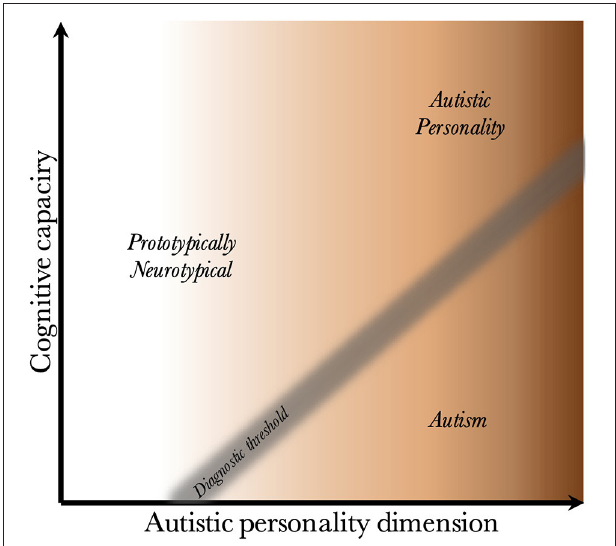
FIGURE 4 | The autistic personality type in relation to neurotypical individuals and those with autism. Illustration how the two clinically neurotypical groups above the diagnostic threshold compare with diagnosed individuals. It shows that individuals with an autistic personality differ from prototypically neurotypical individuals with regard to their position on the autistic personality dimension. It also shows that the difference between having a diagnosis, or not, is contingent on differences in the NB/CC-complex (the result of the interaction between the neuropathological burden and its effect on cognitive